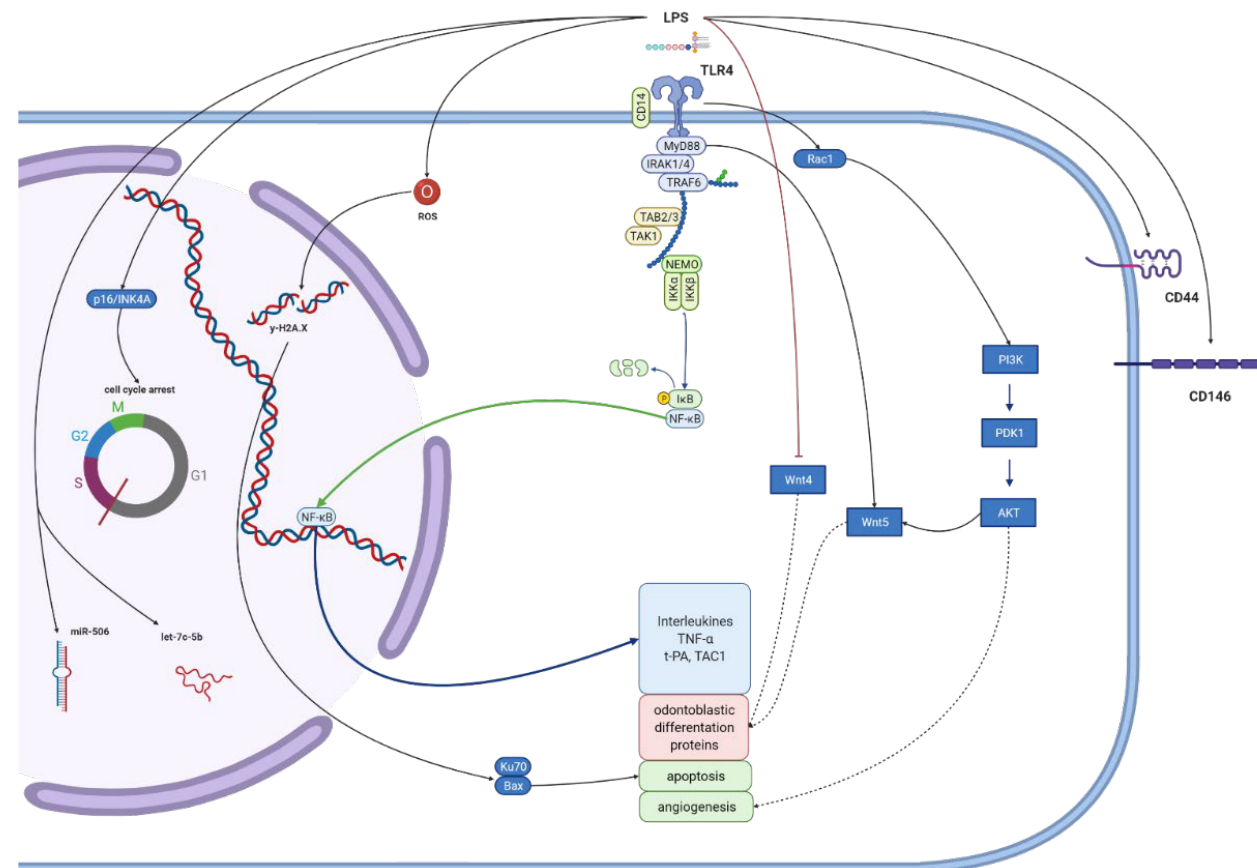
with their names. Black arrows represent positive stimulation, dashed arrows show indirect activation, red ones—inhibition, yellow—ubiquitination, green— translocation to another cell compartment. Created with BioRender.com 7.12.2020.